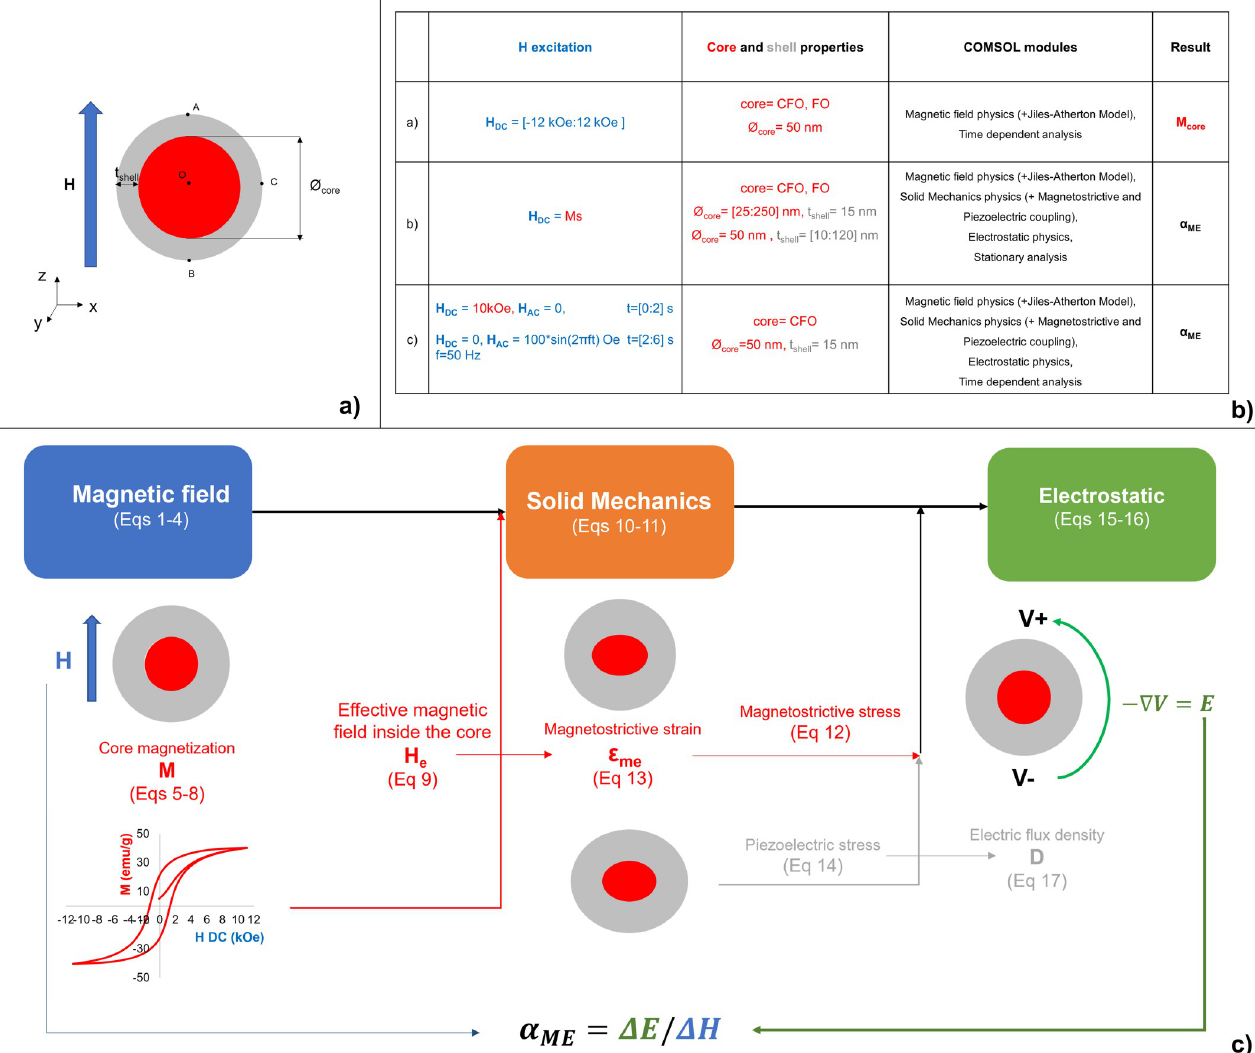
Fig 5. Magnetization of MENP under DC+AC stimulation. Magnetization M(emu/g) (red line) of a CFO core ( Ø core = 50 nm)-BTO shell (t shell = 15 nm) nanoparticle under a DC+AC external magnetic field (H (Oe)- blue line) directed along z. a) M(emu/g) as a function of 2 seconds DC high amplitude (H = 10 kOe) magnetic field followed by 4 seconds weak AC (f = 50 Hz, 100 Oe) magnetic field excitation. b) Magnification of Fig 5A in five AC excitation periods.